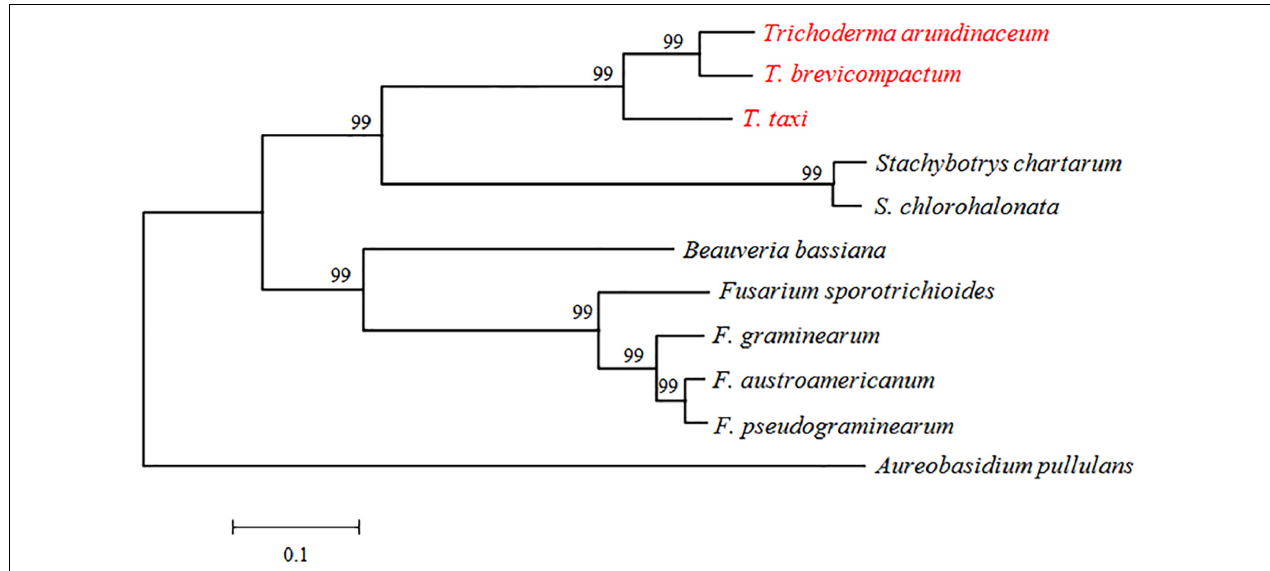
FIGURE 2 | Phylogenetic tree based on alignment of TRI3 from Trichoderma , Stachybotrys , Beauveria , Fusarium , and Aureobasidium . The species were chosen as representatives of hits from a BLASTp search. Sequence alignment and tree building were performed by MEGA5.0 using the neighbor-joining method, and phylogeny was tested by 500 bootstrap replications. The numbers on branches were calculated bootstrap values. The accession numbers for TRI3 genes were as follows: TaTRI3 (CAY87361), TbTRI3 (CBY93780), Stachybotrys chartarum TRI3 (KEY64037), Stachybotrys chlorohalonata TRI3 (KFA68878), FgTRI3 (BAC22114), FpTRI3 (XP_009263555), FaTRI3 (AAM48923), FsTRI3 (AAK33072), BbTRI3 (XP_008602023), and ApTRI3